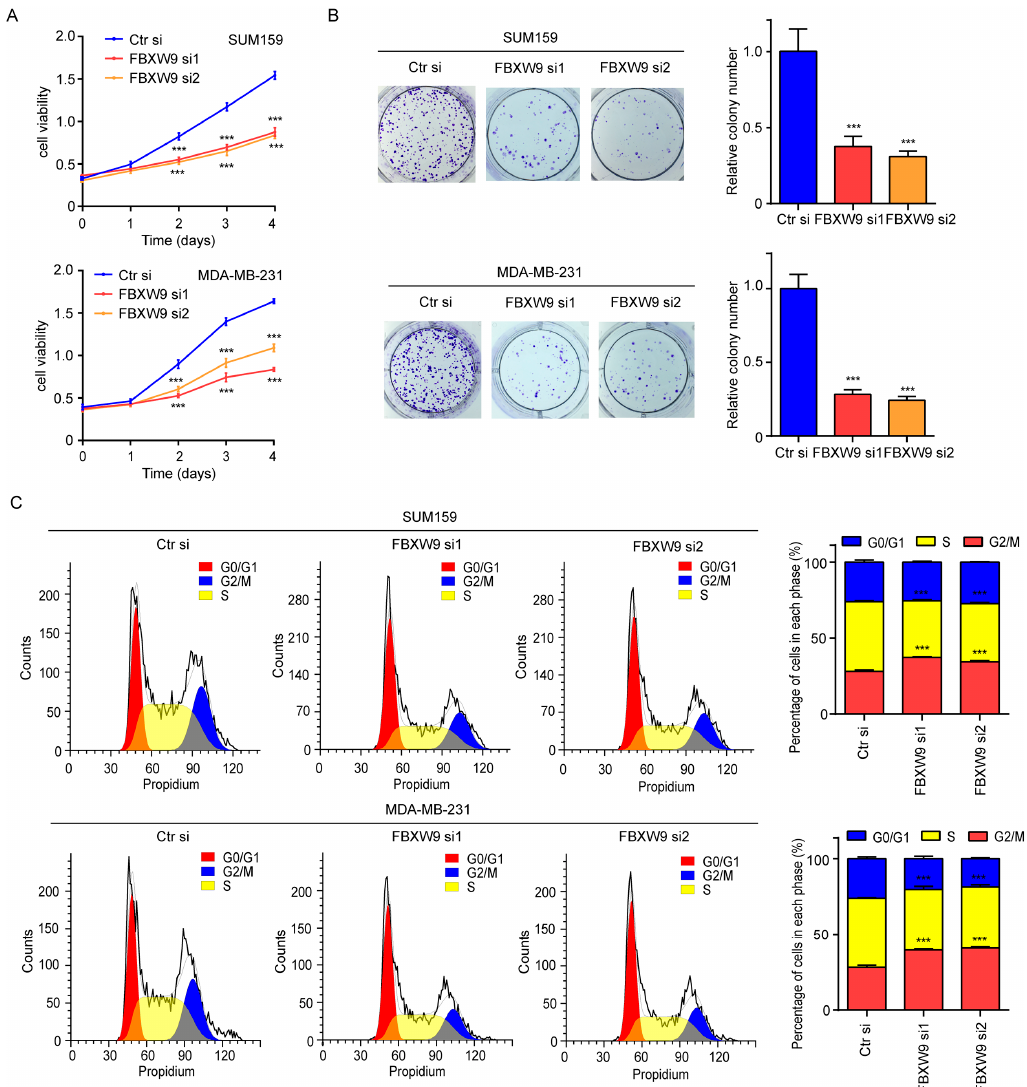
Figure 9. Downregulation of FBXW9 inhibited cell proliferation and cell cycle progression in breast cancer cells. ( A ) The CCK8 analysis was performed on SUM159 cells and MDA-MB-231 with transfection of Ctr si, FBXW9 si1, or FBXW9 si2. ( B ) The colony-forming assay was performed on SUM159 and MDA-MB-231 cells with transfection of Ctr si, FBXW9 si1, or FBXW9 si2. ( C ) Flow cytometry analysis of cell cycle distribution of SUM159 and MDA-MB-231 cells with transfection of Ctr si, FBXW9 si1, or FBXW9 si2. ***, p < 0.001.